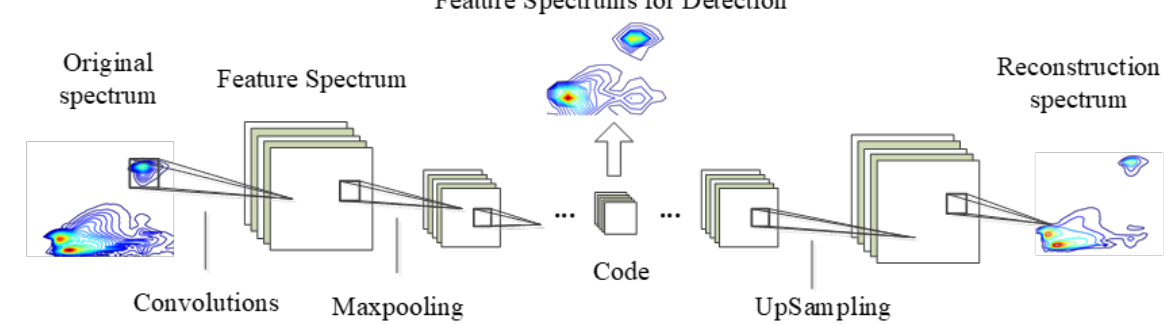
Figure 2. Representation of the procedure based on convolutional autoencoder aimed at excitation-emission matrix feature